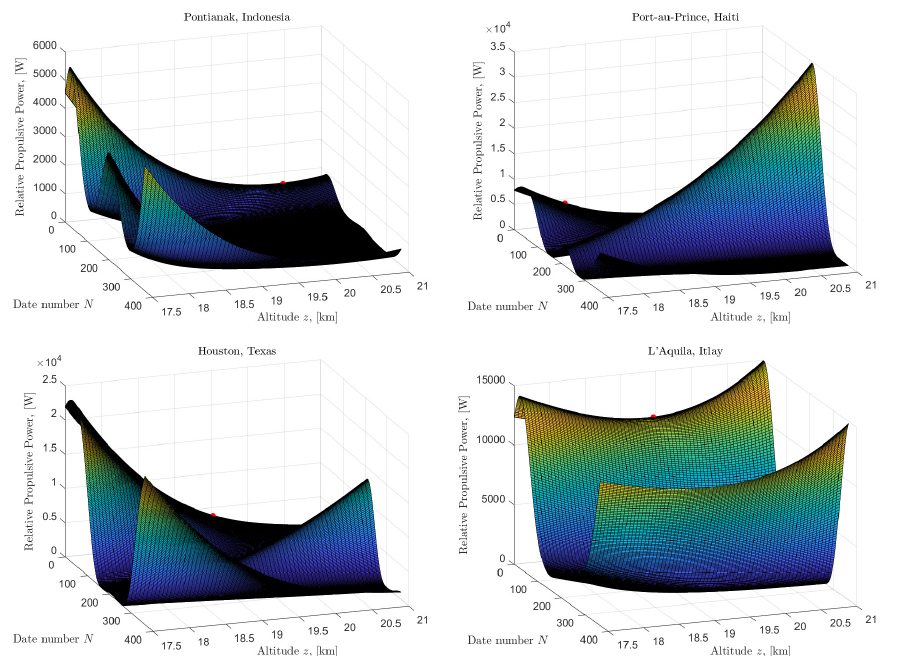
Figure 10. Three-dimensional surface representing the relative propulsive power required for station keeping on each day of the year (at midnight), at altitudes between 17.5 km and 21 km. ( Top row ): ( left ), Pontianak, ( right ), Port-au-Prince. ( Bottom row ): ( left ), Houston, ( right ),